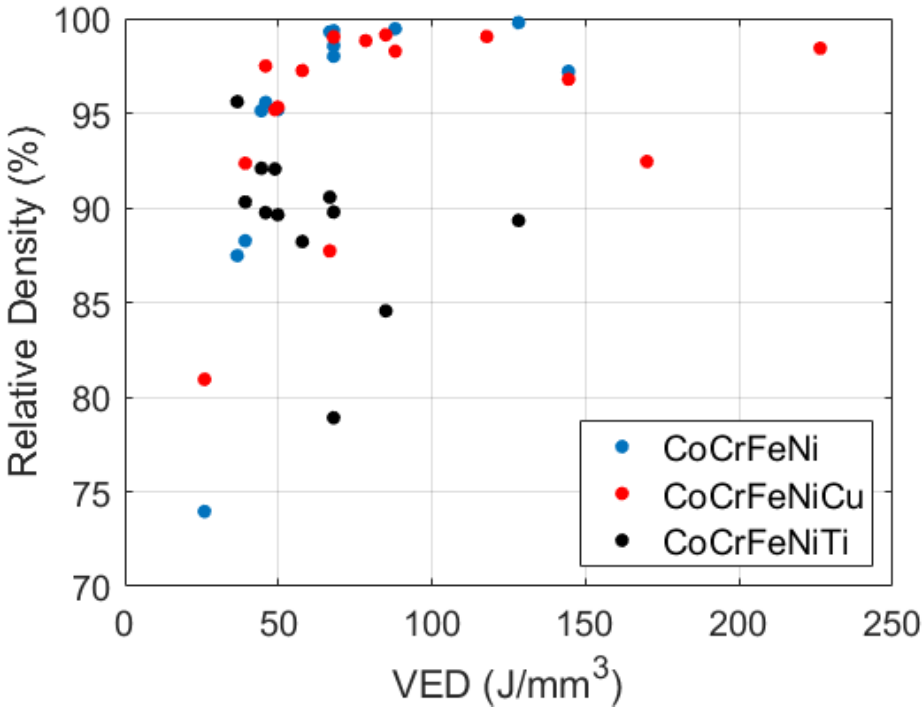
Figure 3. Plots for each alloy, showing relative densities of each part for the corresponding input